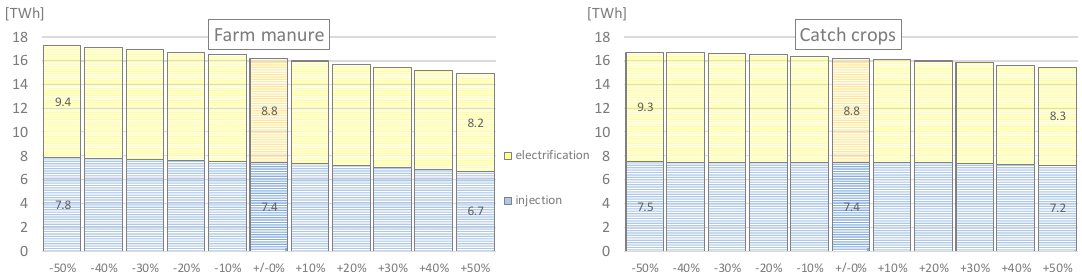
Figure 4. Changes in the biomethane injection and electrification potential based on changes in the minimum amounts for farm manure ( left ) and catch crops ( right ) (own analysis).